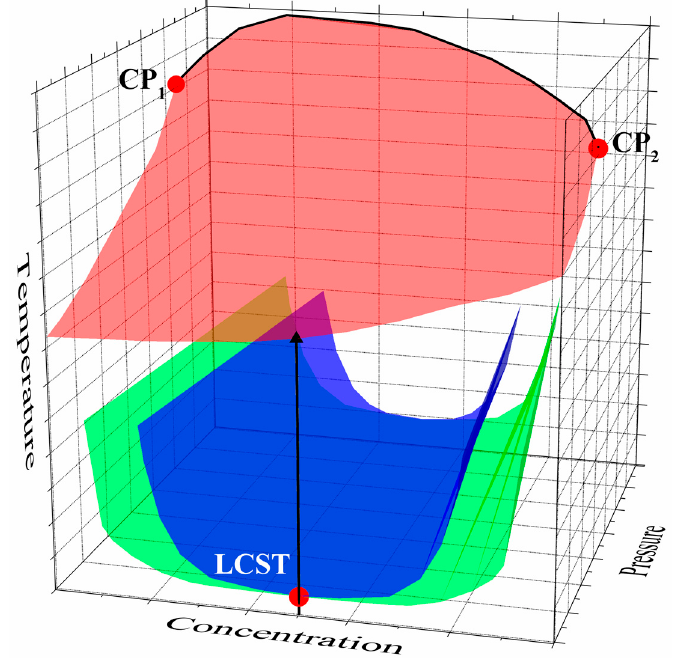
Figure 1. Phase diagram of a two-component partially miscible mixture with a lower critical solution temperature: black line—critical curve of the mixture; red surface—lines of attainable superheating of a mixture of a given concentration c . CP 1 —critical liquid–vapour point of the first component of the mixture; CP 2 —critical liquid–vapour point of the second component of the mixture; blue surface—diffusion spinodal of the mixture; green surface—liquid–liquid binodal of the mixture; LCST—lower critical solution temperature.